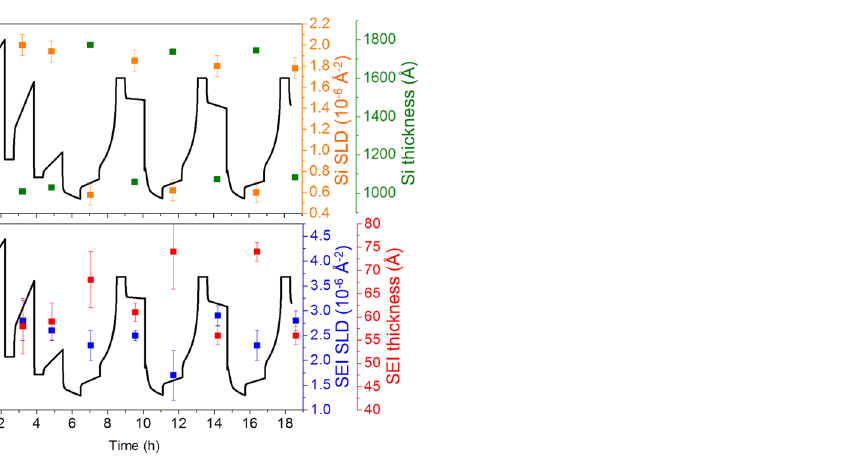
Figure 3. Plots of SLD values and layer thicknesses as a function of state of charge for silicon (top) and the SEI